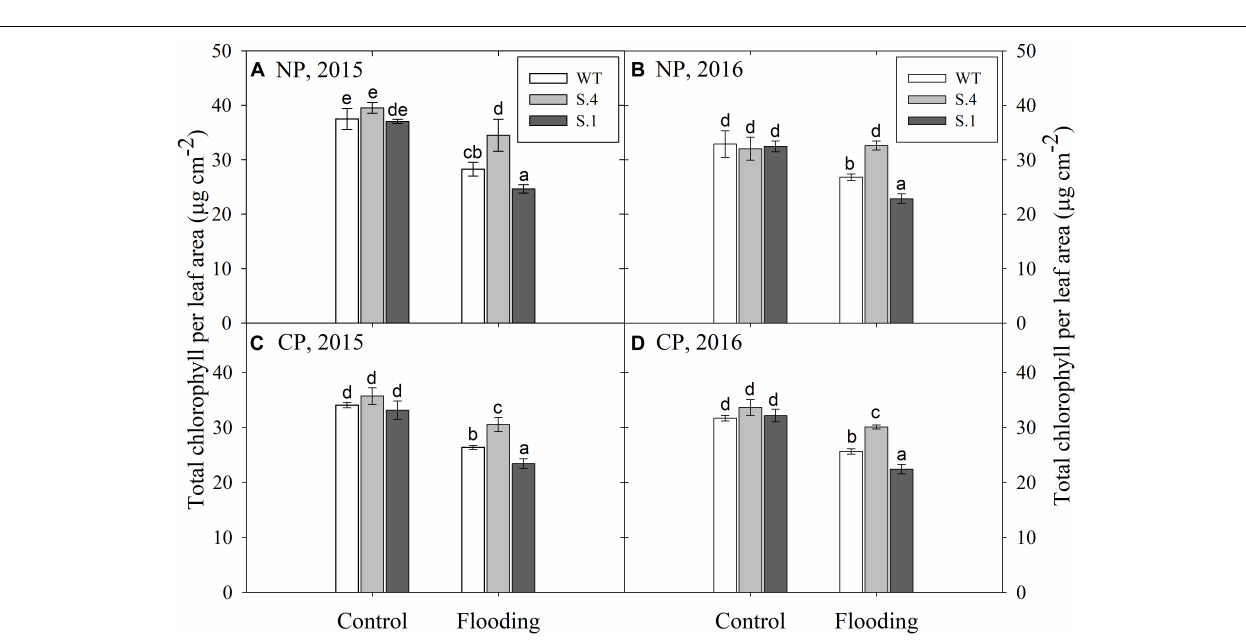
FIGURE 3 | Percentage of leaves (dried or dropped) detected in plant during the flooding stress grown under NP (A) and CP (B). No abscission events have been detected in plant grown under normoxic condition ( n = 5 biological replicate samples, ± SD). Different letters indicate statistical significance for P < 0.001. In the case of low value of SD, the bar is covered by the symbol.